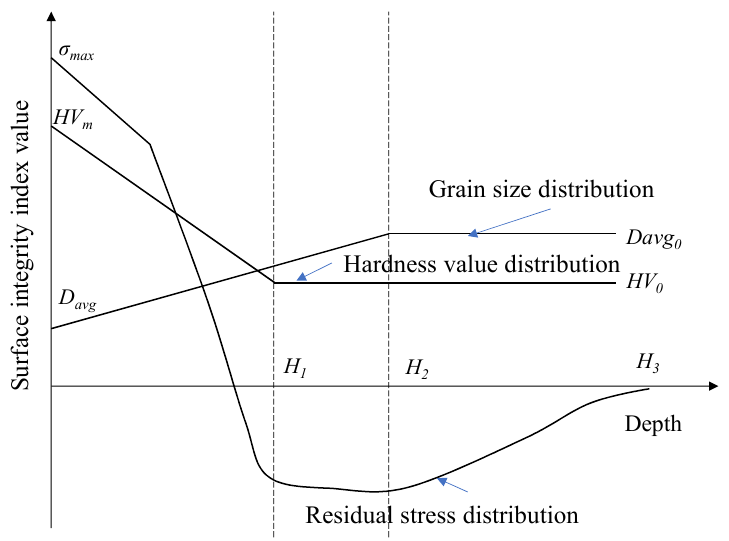
Figure 1. Gradient distribution of the surface integrity characterization parameters.